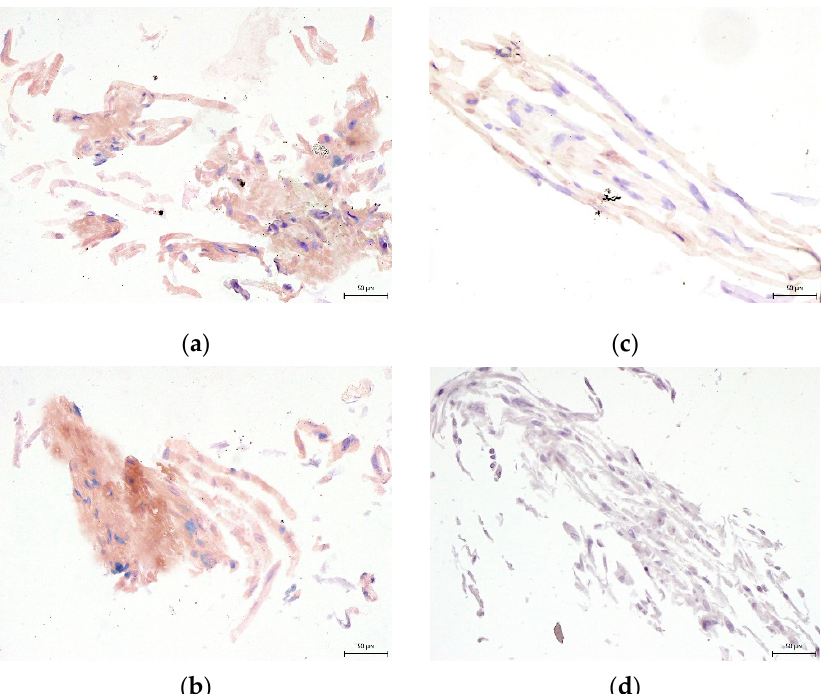
Figure 10. Immunocytochemical detection of osteocalcin, one of the main proteins of the extracellular osteogenic matrix. Samples of DPSCs are after 3-week cultivation in osteogenic differentiation medium. Osteocalcin is revealed as brown areas: ( a ) 10% DMSO cryomedium; ( b ) 3% DMSO cryomedium; ( c ) 3% DMSO + 0.1% HMW-HA cryomedium; ( d ) non-differentiated DPSCs. Scale bar 50 µ m.